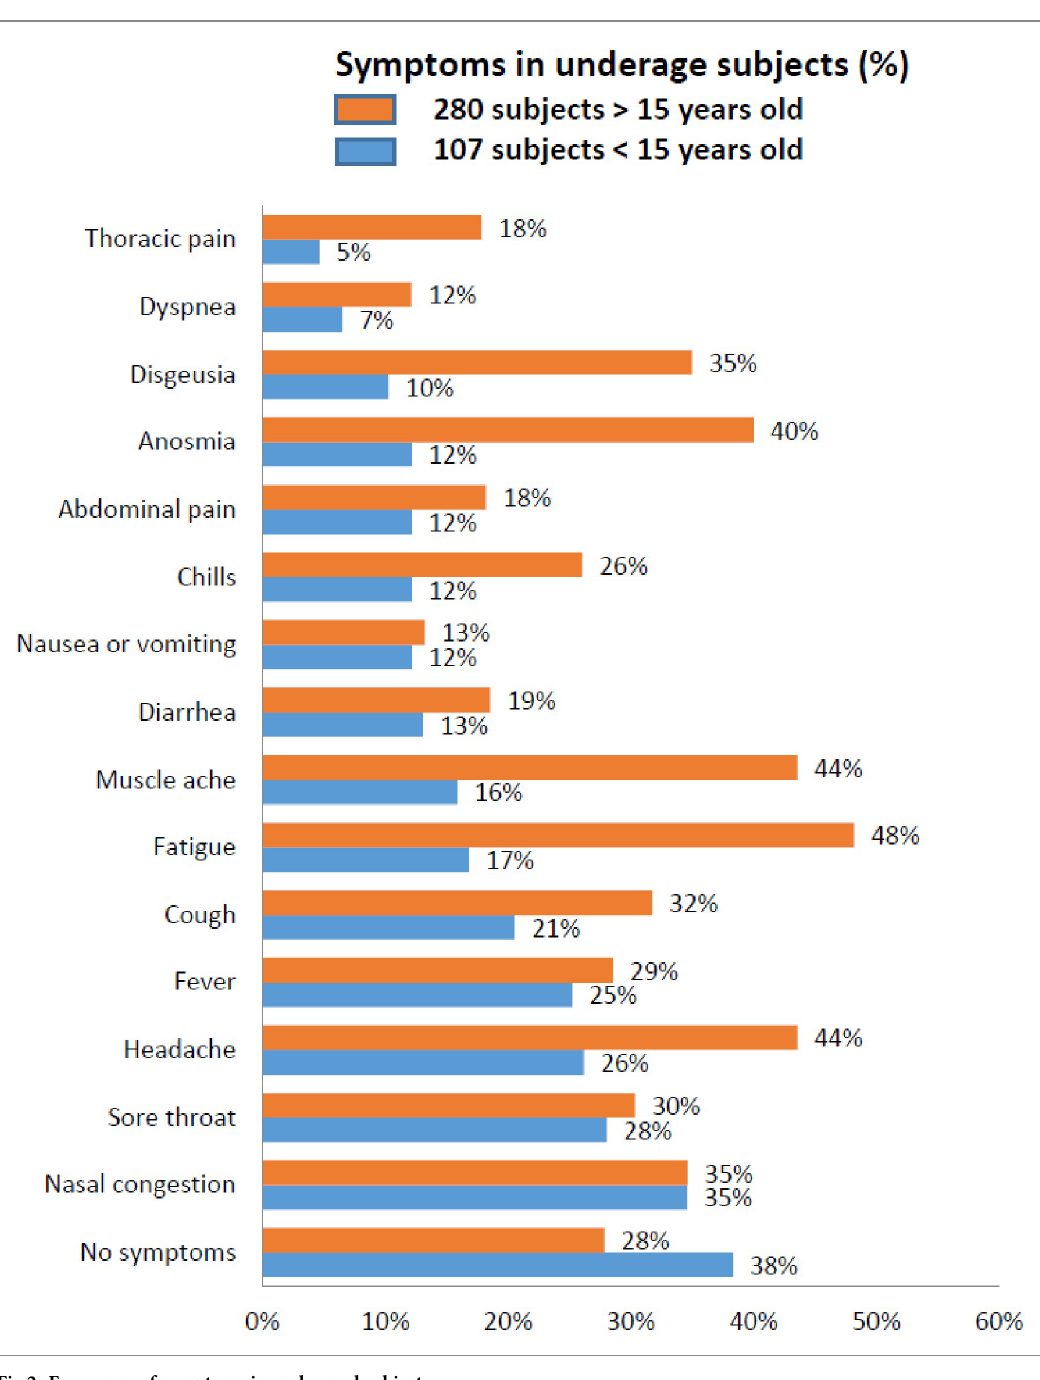
Fig 2. Frequency of symptoms in underaged